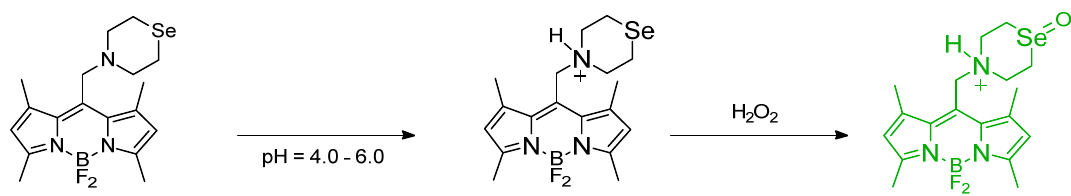
Figure 41. BODIPY system containing an aliphatic Se and protonated amino group synthesized by Xu and Xian.